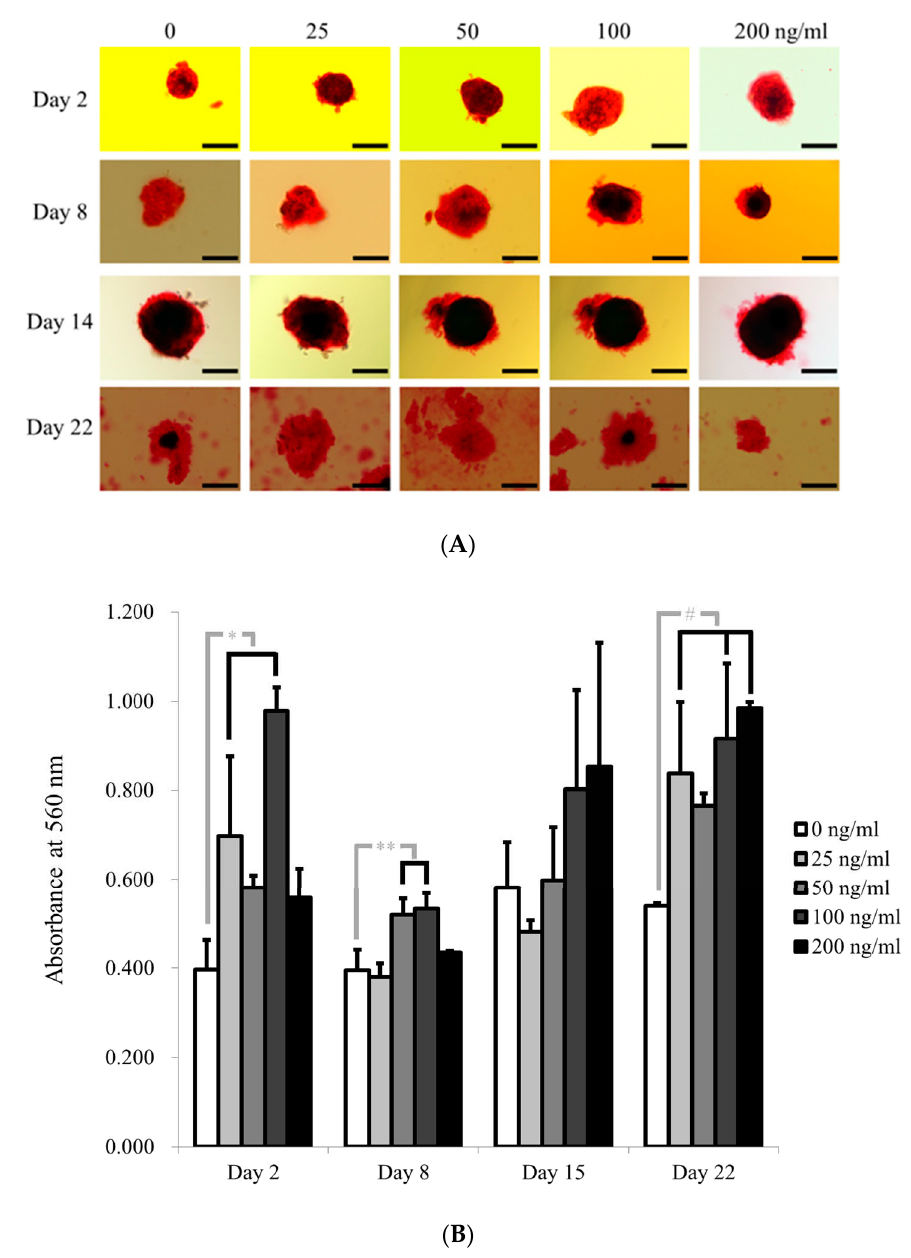
Figure 6. ( A ) Alizarin Red S staining on Days 2, 8, 14, and 22 with the length of the scale of 200 µ m. ( B ) Quantification results of Alizarin Red S staining on Days 2, 8, 15 and 22. * p < 0.05 vs. the 0 ng/mL group on Day 2. ** p < 0.05 vs. the 0 ng/mL group on Day 8. # p < 0.05 vs. the 0 ng/mL group on Day 22.